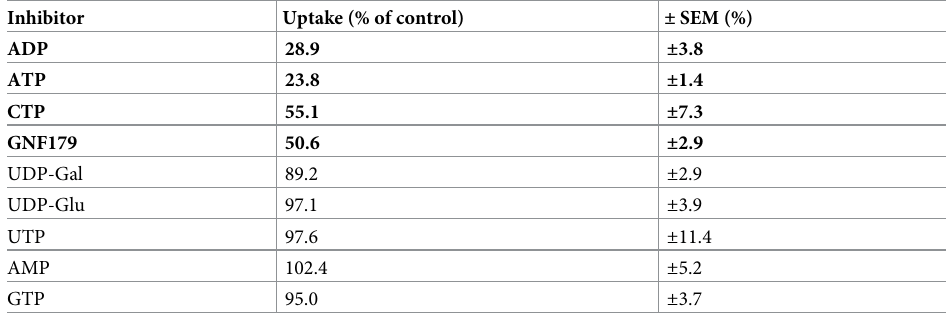
95.0 ± 3.7 To test the substrate specificity of PfANT, a mixture of 25 nM [ α - 32 P] ATP and non-radioactive potential substrate at one-hundred-fold concentration was used to detect the inhibitory effect. E . coli cells expressing PfANT absorb of 25 nM of [ α - 32 P] ATP for 15 min were used as control. Means ± s.e.m., four independent